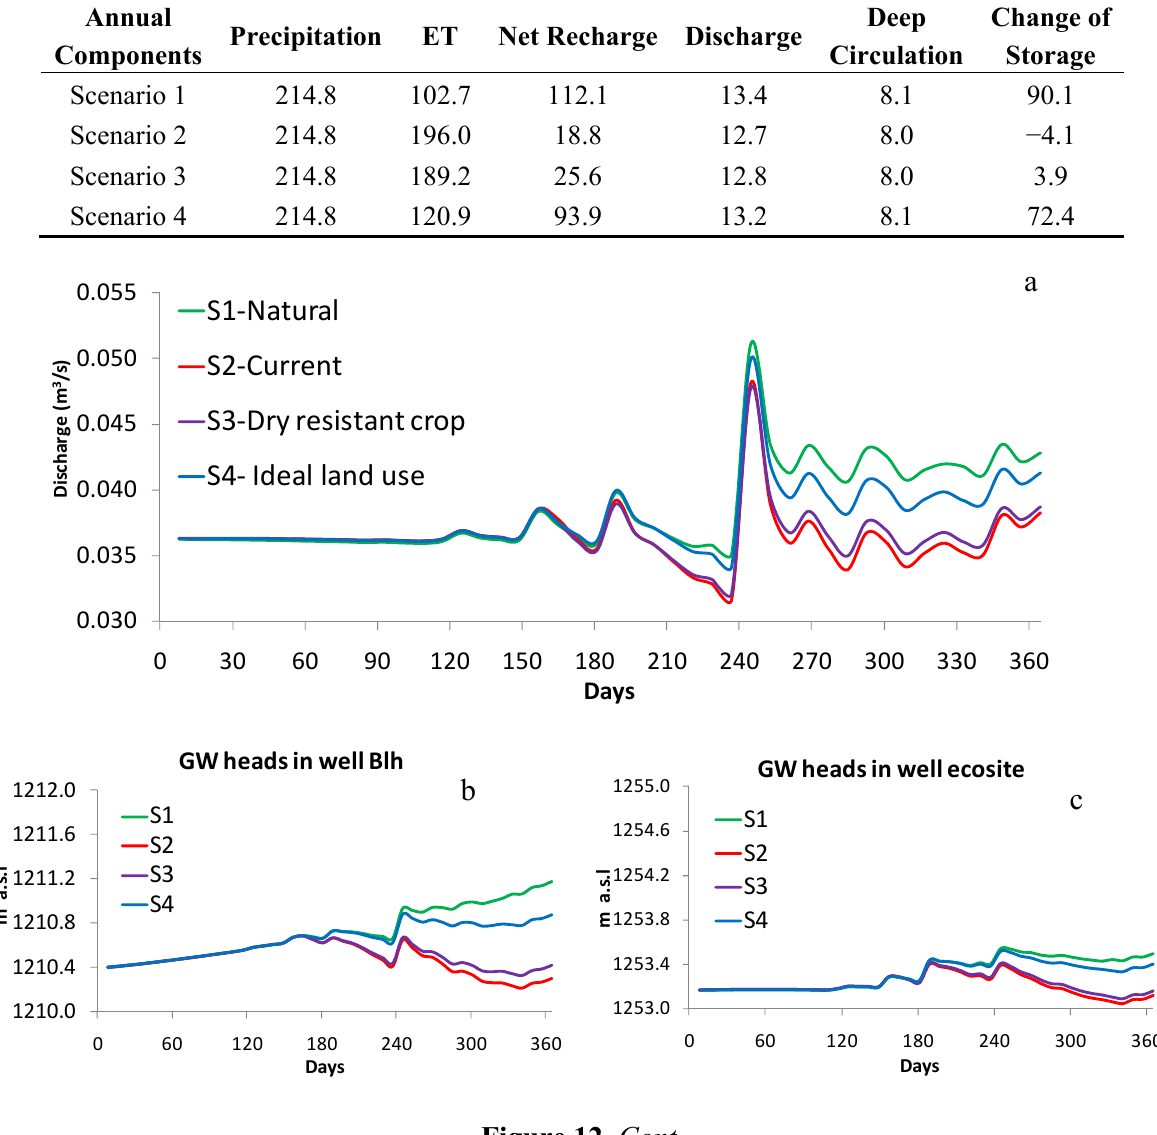
Table 4. Comparison of simulated water balance for four scenarios